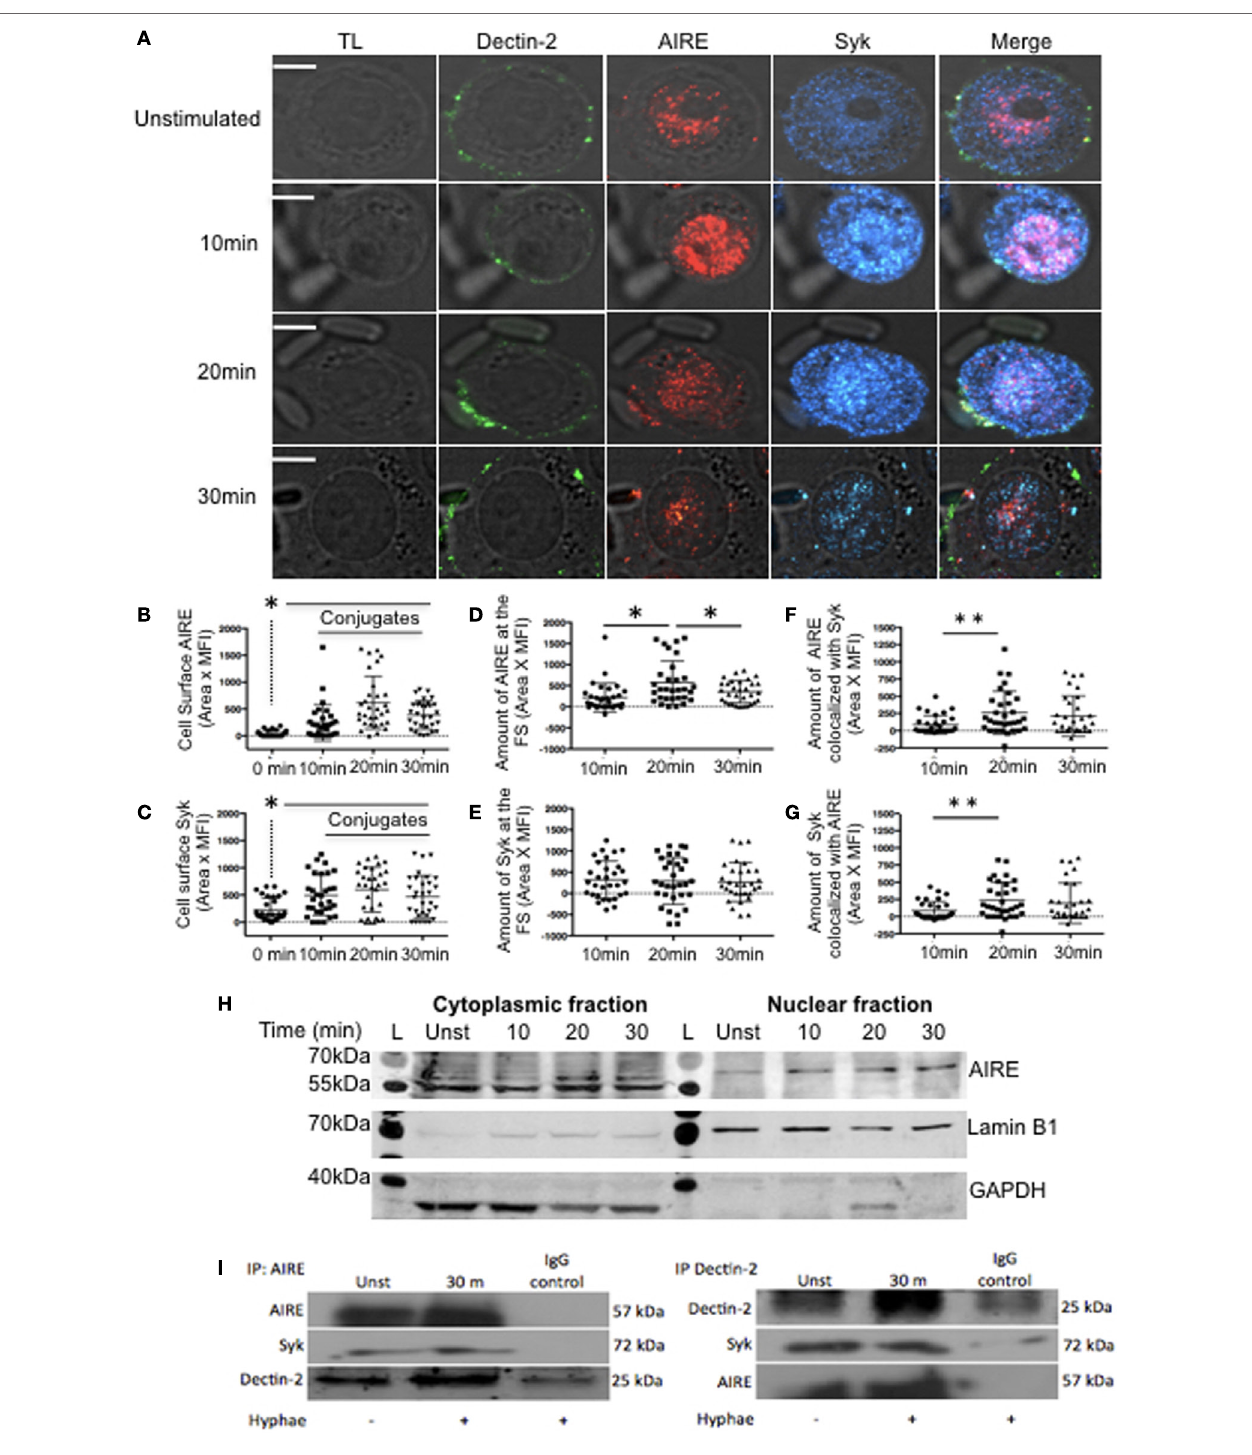
FigUre 2 | Dectin signaling at fungal synapse (FS). (a) Representative confocal micrographs of macrophage-like THP-1 cells, unstimulated (0 min) or stimulated with C. albicans hyphae for 10, 20, or 30 min to observe the recruitment of Dectin-2 (green), Syk (blue), and autoimmune regulator (AIRE) (red) to the FS. (B–g) Each dot represents a cell used for the measurement indicated. The horizontal bar in each column denotes the mean. * p < 0.05 as determined by the t -test. (B,c) Amounts of AIRE (B) and Syk (c) on the cell surface. (D,e) Amounts of AIRE (D) and Syk (e) at the FS (conjugated–unconjugated). (F,g) Synaptic co-localization of AIRE with Syk (F) or of Syk with AIRE (g) . (h) Western blotting analysis of AIRE in cytoplasmic and nuclear fractions from macrophage-like THP-1 cells, unstimulated (unst) or stimulated with hyphae for 10, 20, or 30 min. (L) Ladder, GAPDH and Lamin B1 was used as loading control. (i) Lysates from macrophage-like THP-1 cells, unst or stimulated with hyphae for 30 min, were immunoprecipitated with AIRE (left panel) or Dectin-2 antibodies (right panel) and with a control antibody (IgG). The immunoprecipitated products were probed for AIRE, Dectin-2, and Syk as indicated. Representative confocal micrographs of 30 cells counted in 3 independent experiments. Scale bar = 5